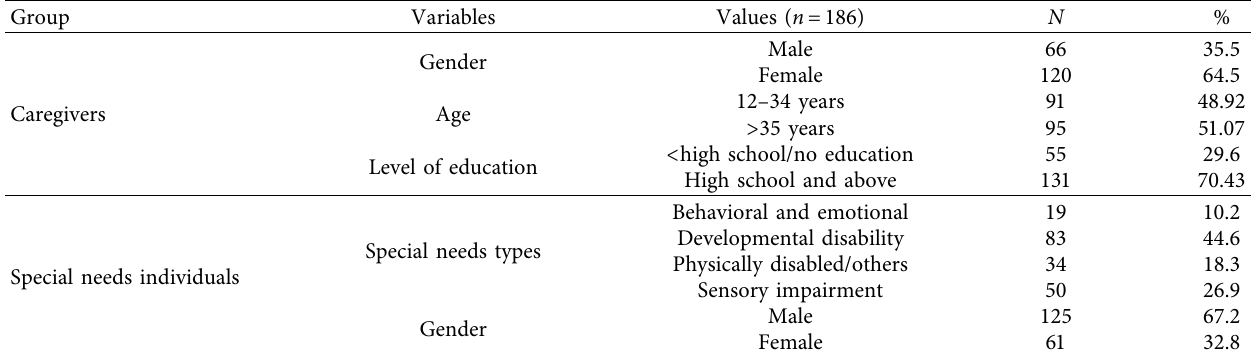
Table 1: Demographic distribution of study